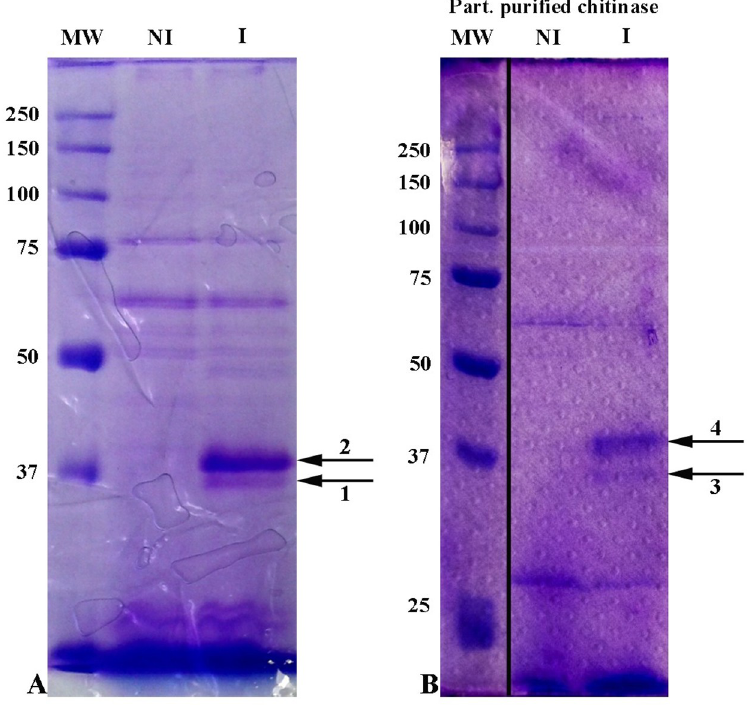
Fig 1. SDS PAGE analysis of supernatant of non-induced (NI) and induced (I) Curtobacterium cultures (A); and partially purified chitinase from ion exchange chromatography (B). Image splicing is denoted by vertical black line on the figure Fig 1B because fragments of the same original image were spliced together to remove irrelevant lanes. Fig 1A and 1B are representing different